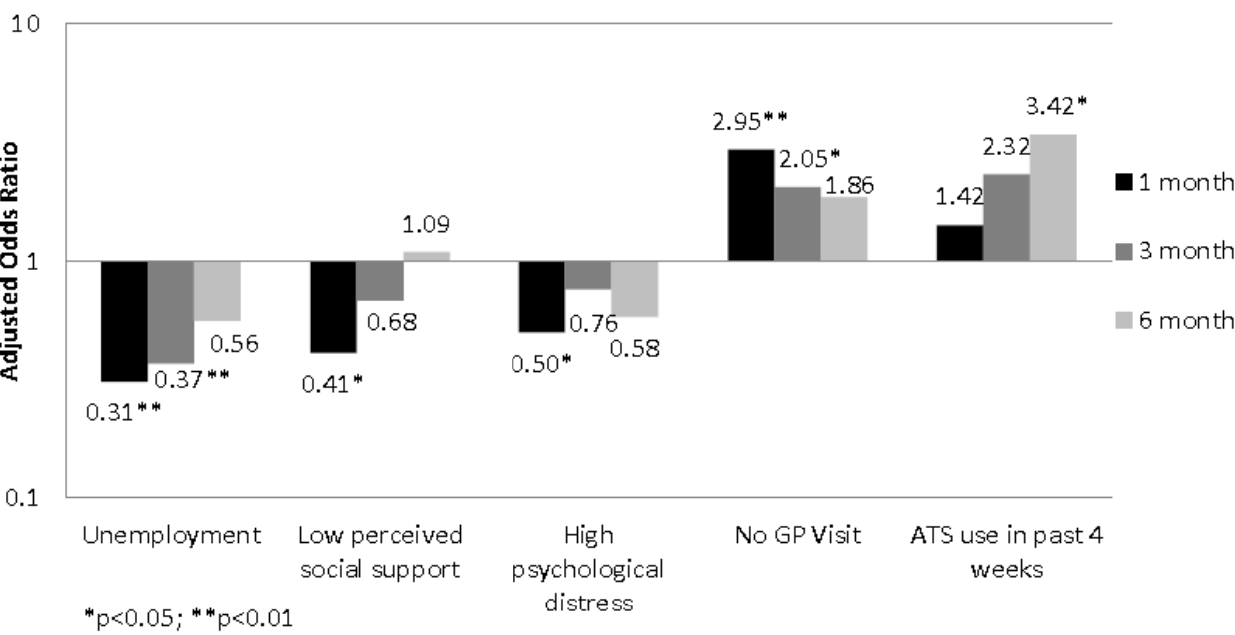
Figure 1. Adjusted odds ratios of post-release outcomes for adolescents versus adults (reference category).